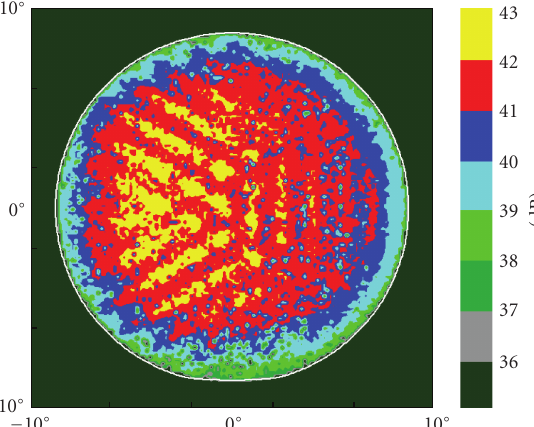
Figure 6: Minimum directivity of DBS beams biased for isolation, 7 colour, with errors, (scale 35 to 43